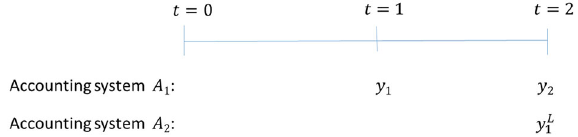
Fig. 1 Accounting systems A 1 and A